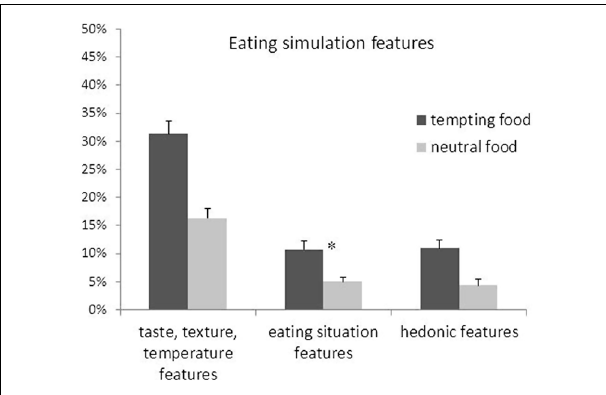
FIGURE 2 | Percentages of each of three types of eating simulation features generated for tempting and neutral food. Error bars denote the standard error of the mean. An asterisk marks a significant difference between tempting and neutral food ( p < 0.001).